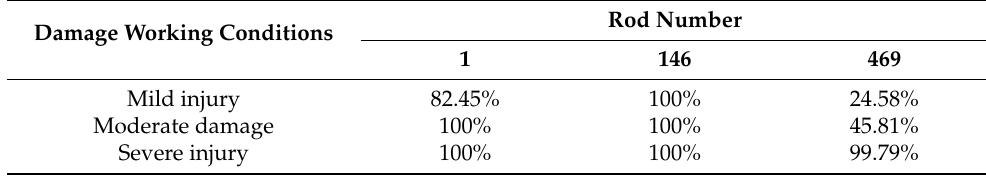
Table 1. Damage probability of each member under different damage conditions.